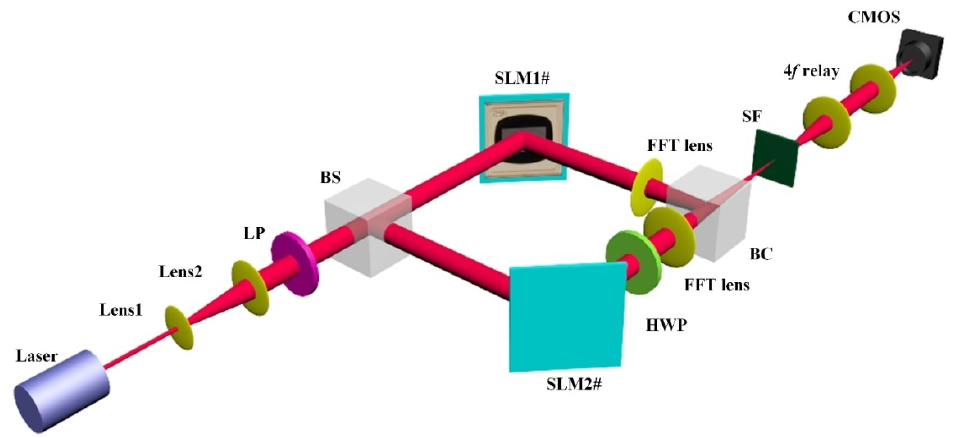
Figure 8. Schematic of the experimental setup, where LP is a linear polarizer, HWP is a half-wave plate, BS is a beam splitter, BC is a beam combiner, and SF is a spatial filter. The laser used in the experiment is a 0.3 mW diode module with a wavelength of 633 nm. The two LCOS SLM devices have a resolution of 1920 × 1080 with a pixel pitch of 5.3 µm and a grey level scale of 0–255. A linear polarizer (LPVISC050) with a diameter of 12.5 mm is used to create the input light with a linear polarization angle of 0° for the system.